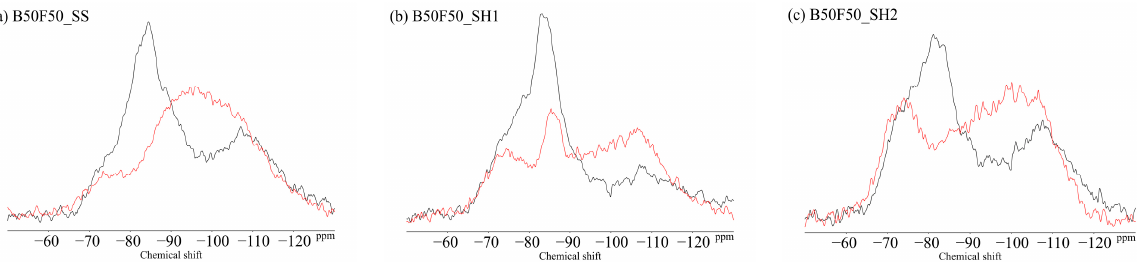
Polymers 2021 , 13 , x FOR PEER REVIEW 13 of 18 Figure 13. Solid-state 29 Si MAS NMR chemical shifts for ( a ) B50F50_SS, ( b ) B50F50_SH1, and ( c ) B50F50_SH2 samples. Figure 13. Solid-state 29 Si MAS NMR chemical shifts for ( a ) B50F50_SS, ( b ) B50F50_SH1, and ( c ) B50F50_SH2 samples. Figure 13. Solid-state 29 Si MAS NMR chemical shifts for ( a ) B50F50_SS, ( b ) B50F50_SH1, and ( c ) B50F50_SH2 samples.